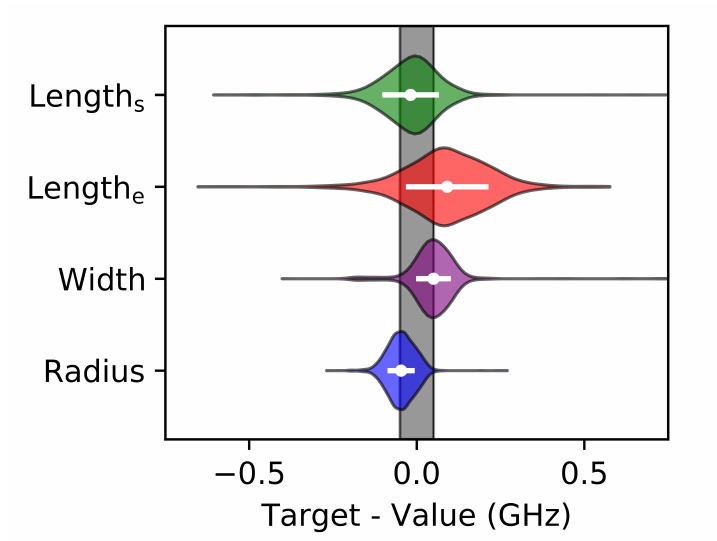
Figure A14. Violin Plots of the measured arm length, width, and spiral center radius. Mapped to frequency space by simulated results. Each parameter is normalized to the target center frequency with an acceptable common band indicated by the shaded grey area.